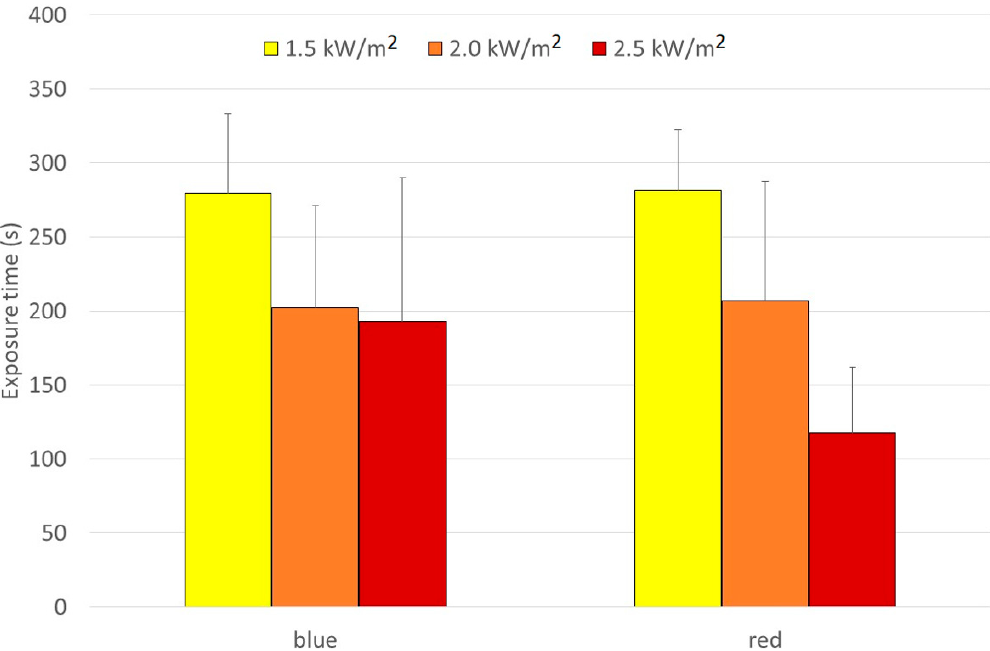
Figure 10. Mean exposure time in blue and red clothing at different radiation levels.